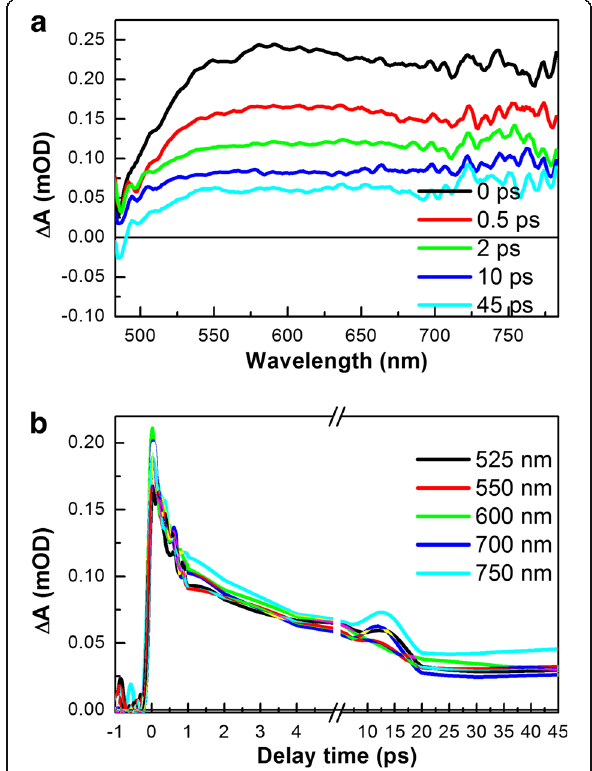
Fig. 3 TAS spectra measured at different time of delay ( a ) and traces recorded at different wavelengths of TAS spectra ( b ) of neat DLC matrix. For the excitation of DLC matrix 7 μ J/cm 2 intensity, 400 nm wavelength was